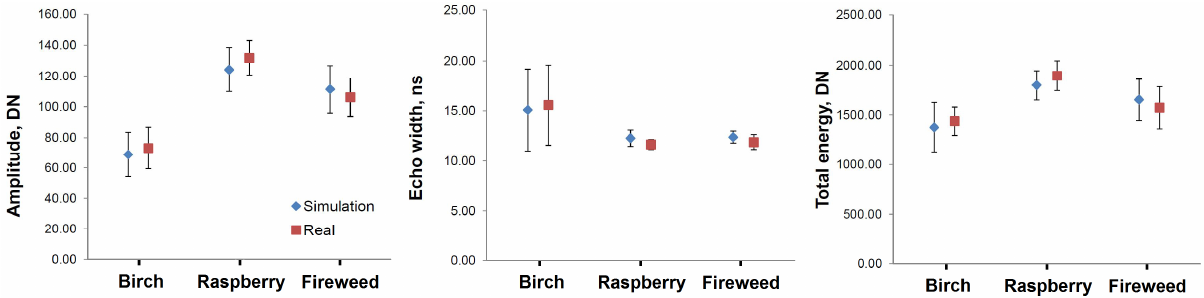
Figure 5. Examples of simulated and real mean WF features in the 2012_10_1 dataset. The whiskers denote standard deviation. Absolute validation of MCRT models is difficult, because the effects of the radiative transfer model, vegetation models, and the sensor response cannot be separated from each other.